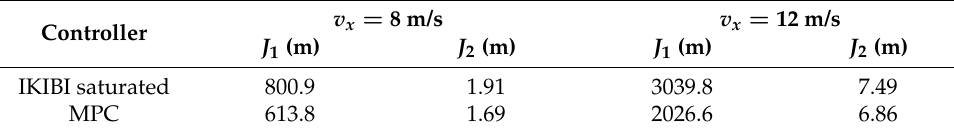
Figure 7. Vehicle path test: noiseless, slow sensor feedback test: ( left ) v x = 8 m/s and ( right ) v x = 12 m/s. Table 3. Cost indexes: noiseless, slow sensor feedback test.